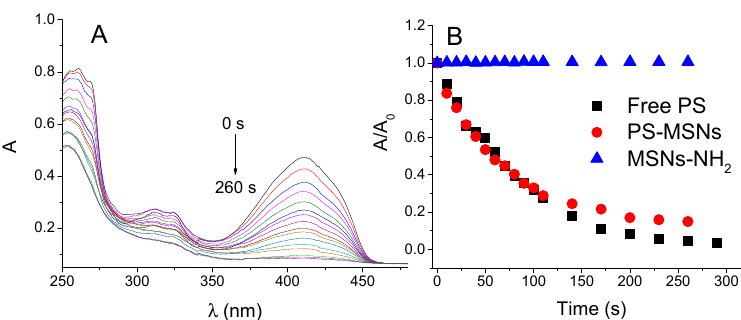
Figure 3. ( A ) Absorption spectral changes of DPBF (25 µM) observed upon irradiation at 532 nm (50 mW) in the presence of PS-MSNs suspension (1 mg mL − 1 ) in ethanol. ( B ) A/A0 ratio at 411 nm of DPBF (25 µM) observed upon irradiation at 532 nm (50 mW) in the presence of free PS and suspensions of PS-MSNs (1 mg mL − 1 ) and MSN-NH 2 (1 mg mL − 1 ) in ethanol.